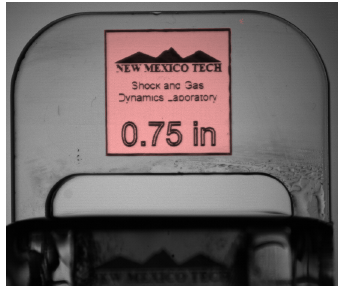
Figure 5. A representative image taken of the focusing plate before testing. The pixel area within the outer square is measured by a MATLAB script and represented by the red region